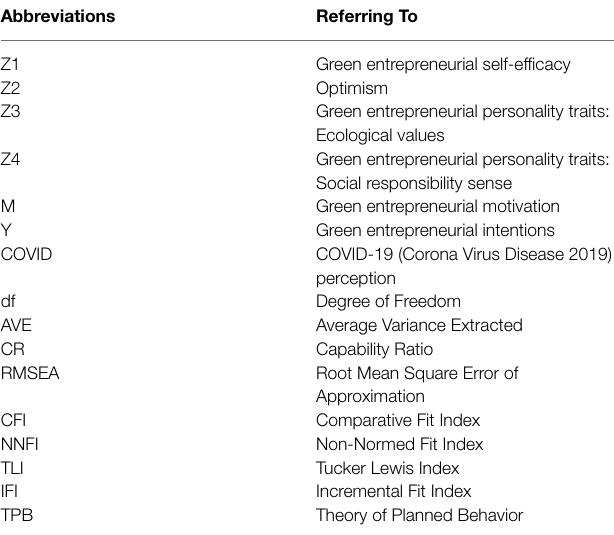
TABLE 7 | List for